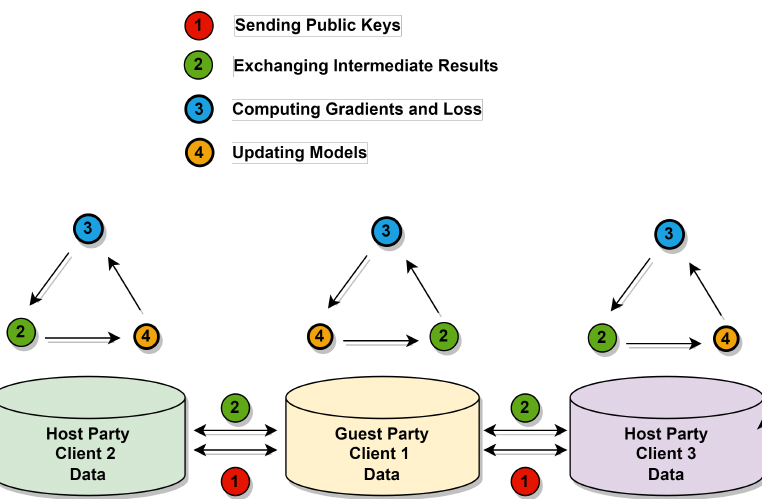
Figure 1. Iterative Federated Learning Environment (Adapted from